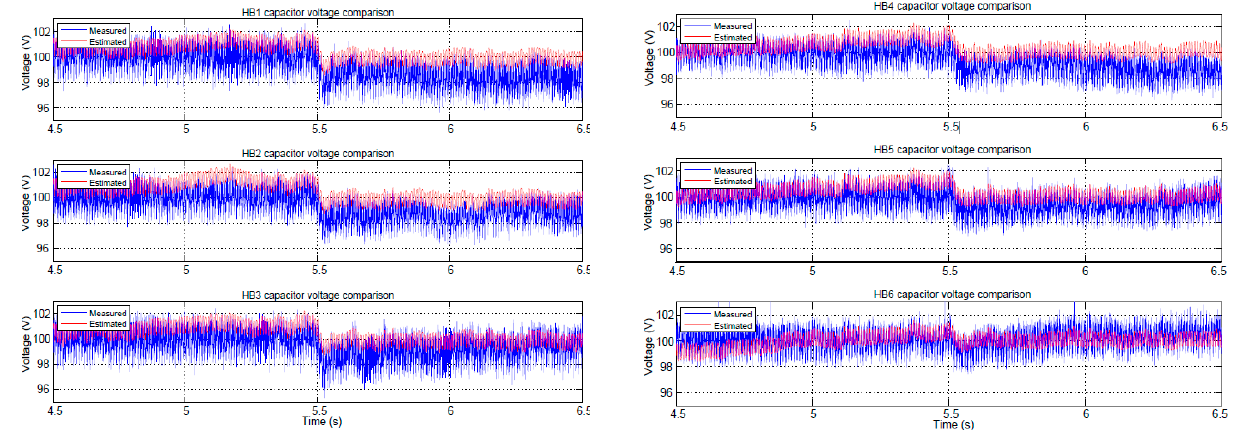
Figure 8. eRTS capacitor voltages estimations of se-branch (HB1–HB3) and de-branch (HB4–HB6) before and after a failure occurring at the instant 5.5 s.